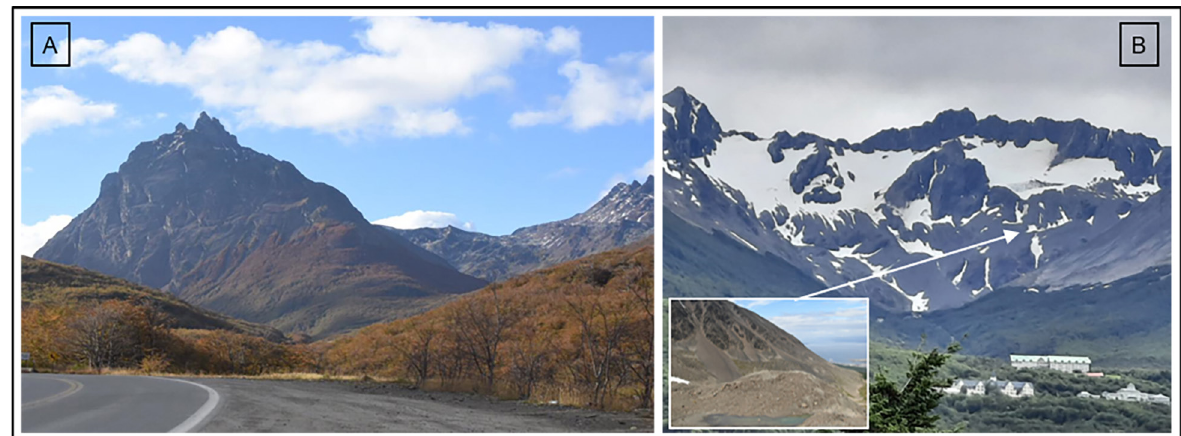
Fig. 9. Glacial features around Ushuaia city. A – Olivia paleo-nunatak and cirques developed in its eastern slope; B – Le Martial cirque glacier and valley; in the small picture a detail of the Late Glacial and LIA moraines are pointed